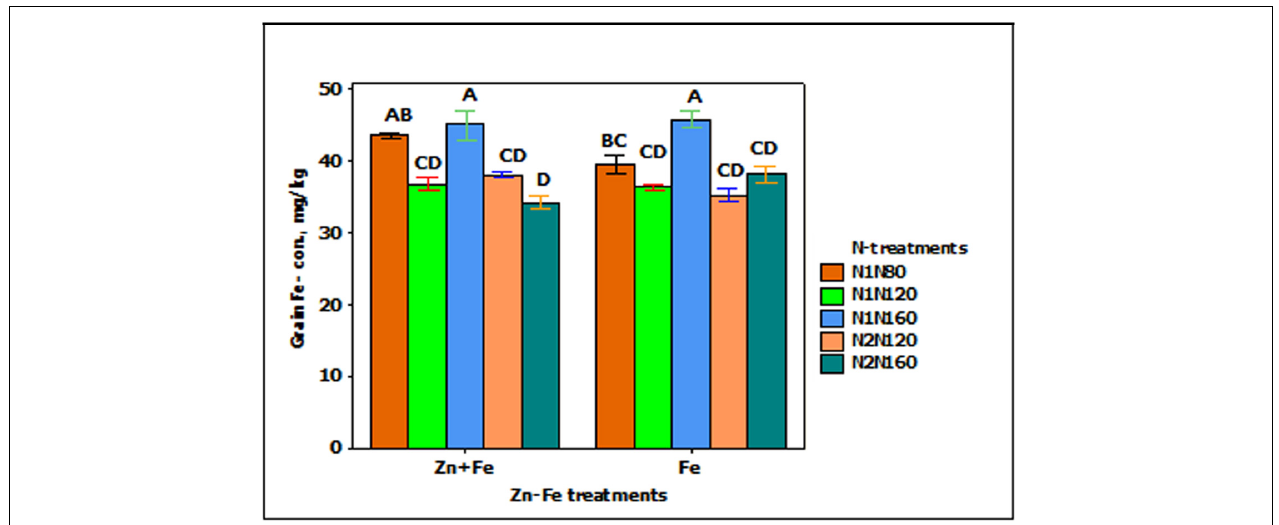
FIGURE 2 | Mean ± 1 SE ( n = 4) bar plot for the responses of grain Fe- concentration at N-treatments when Zn + Fe and Fe applied to growth media at sowing. N1 and N2 for single and split N. 80, 120, and 160 stand for rate of N in kg ha − 1 . Bars with same alphabet at head are not significantly different at 5% level of significance.